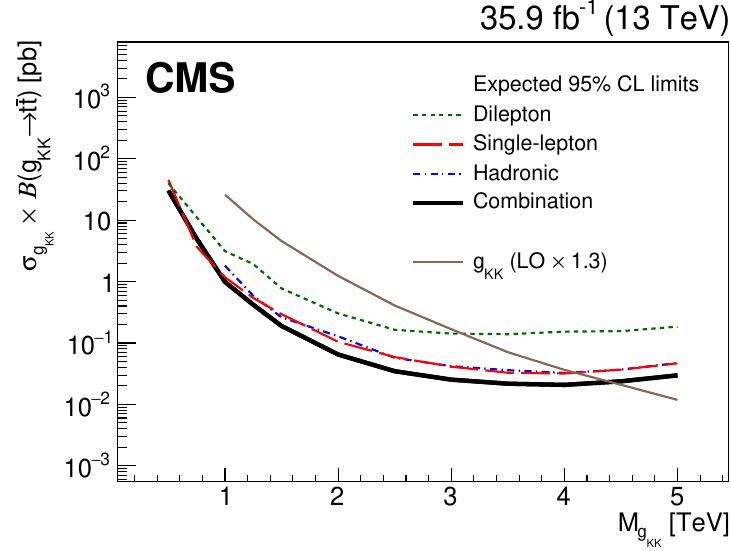
Figure 12 . Comparison of the sensitivities for each analysis channel contributing to the combina- tion. The expected limits at 95% CL are shown for each channel with the narrow colored lines, while the combination result is shown with thick the black line. These results are shown speci(cid:12)cally for the g KK signal hypothesis, as this model has characteristics that are common to many tt resonance searches. The multiplicative factor of 1.3 for the g KK is the NLO K